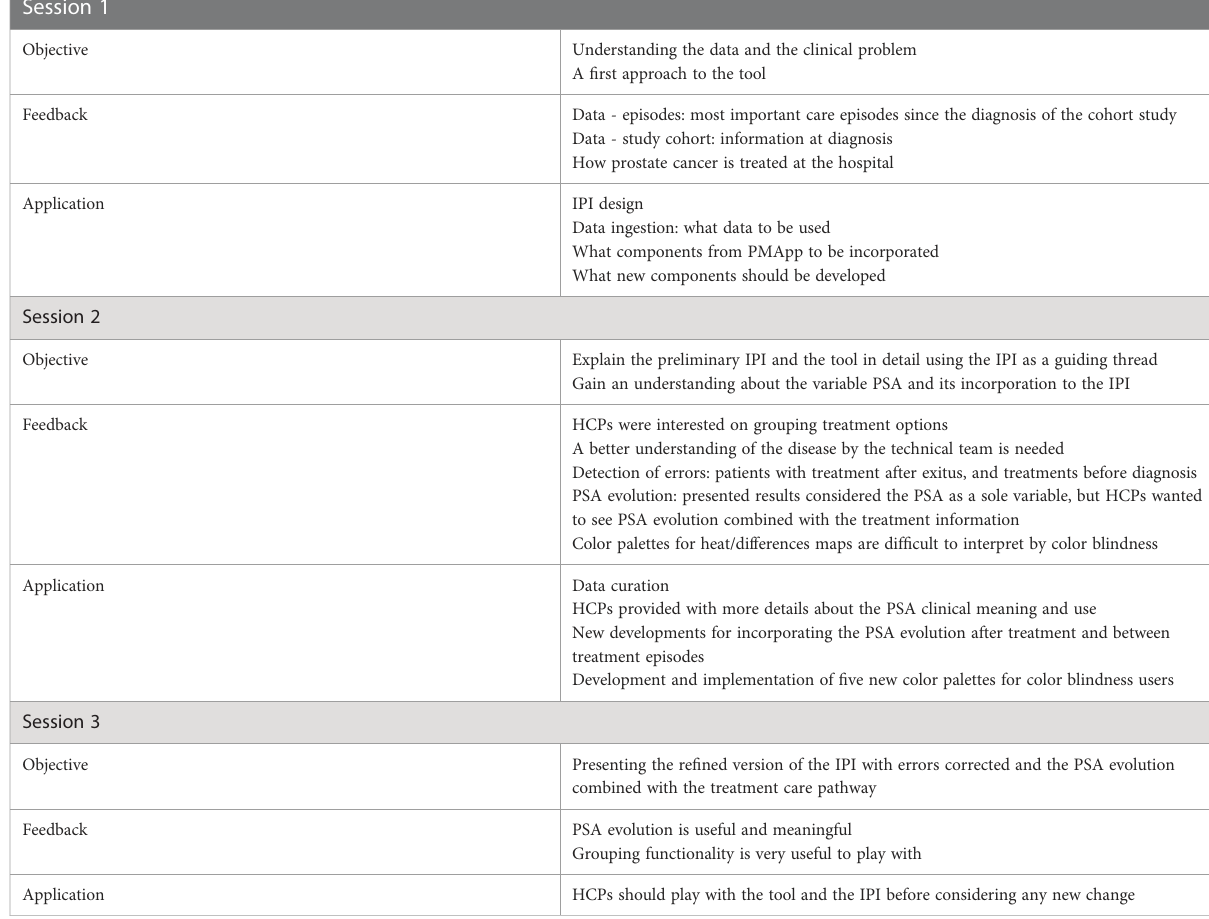
TABLE 3 Summary of main results collected during the Data-Rodeo sessions.